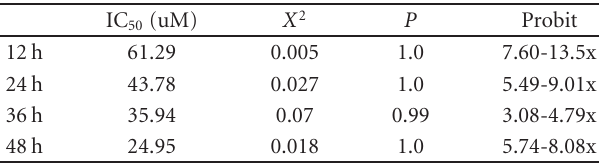
Table 1: IC 50 of UA at di ff erent time points in human gastric cancer cell